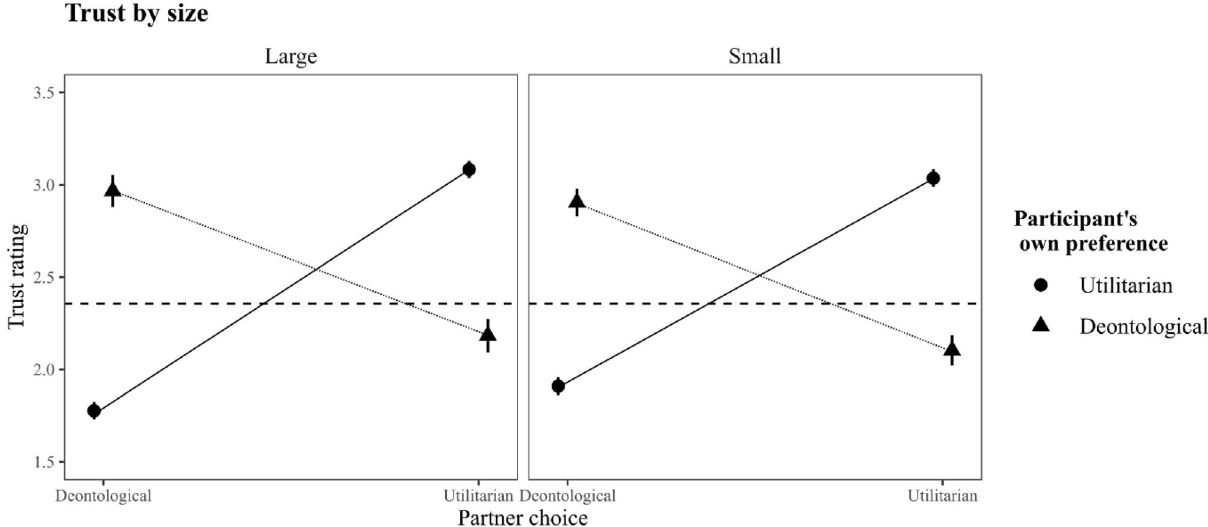
Figure 3. Inferred cooperation as a function of partner judgment, participants’ own moral preference, and whether the sacrificial benefit was either large or small. The horizontal line designates average trust in an unknown partner. Note. 95% Confidence intervals have been drawn but are not easily visible due to their small size.